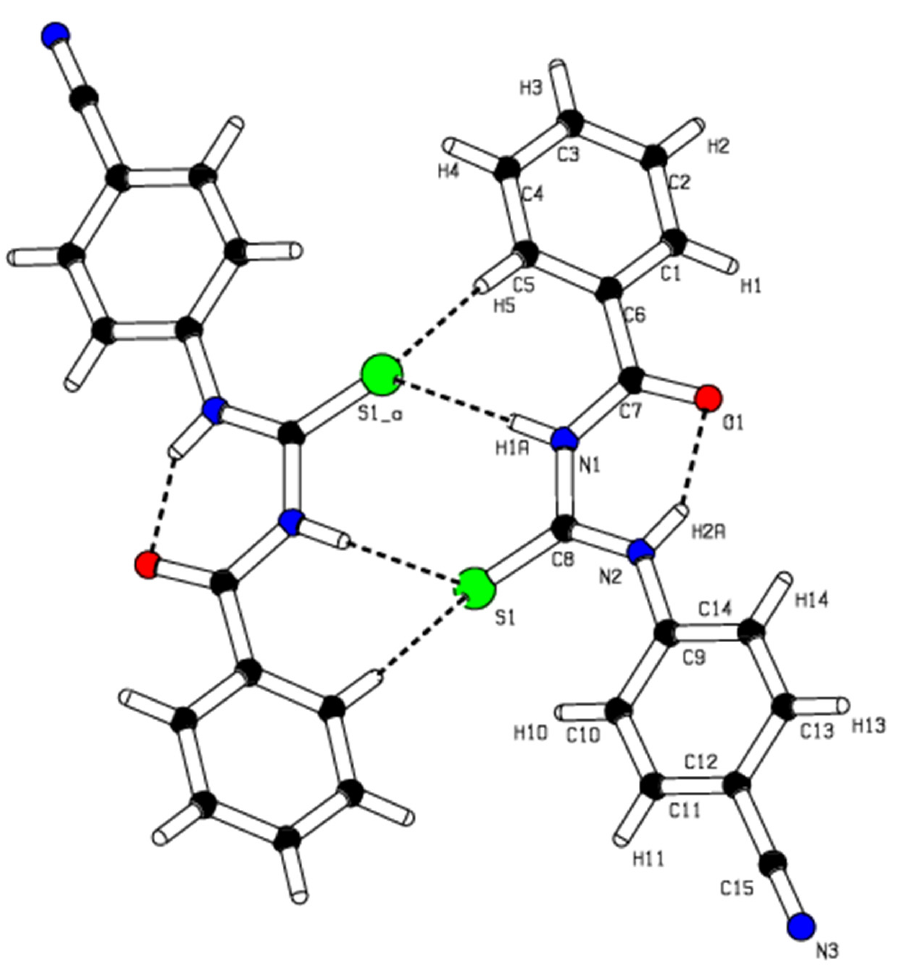
Figure 3. A view of the intermolecular hydrogen bonds N—H…S, and C—H…S for compound I.